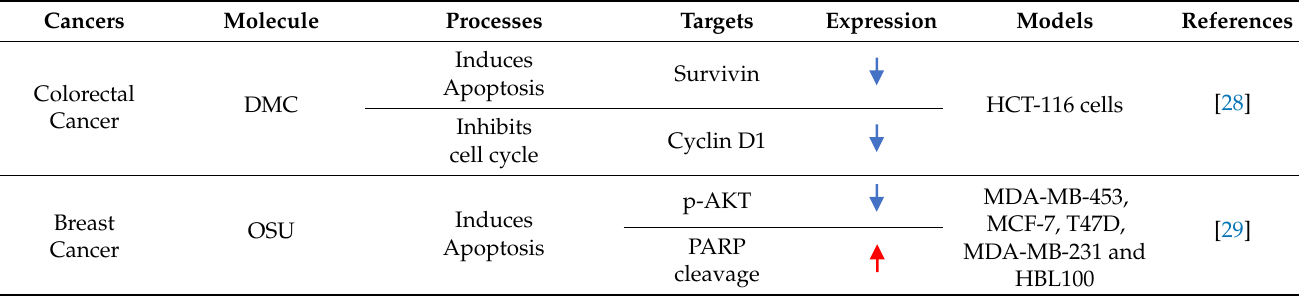
Table 1. Impact of DMC and OSU-03012 in cancers.